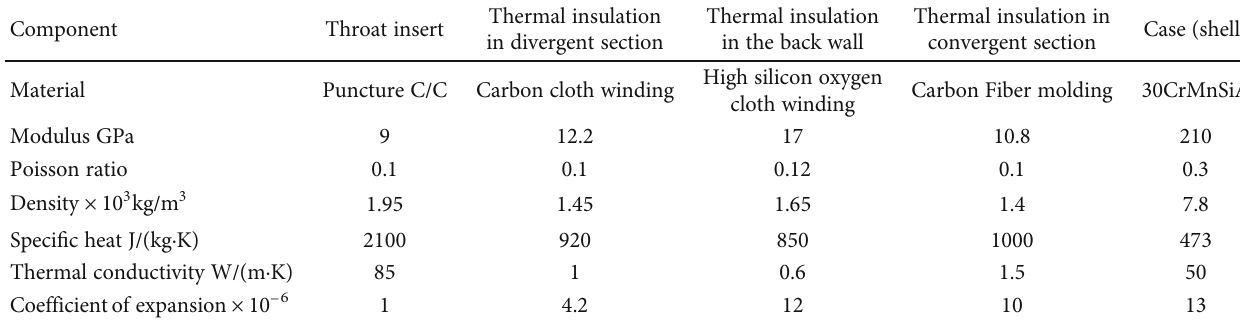
Table 1: Performance parameters of nozzle